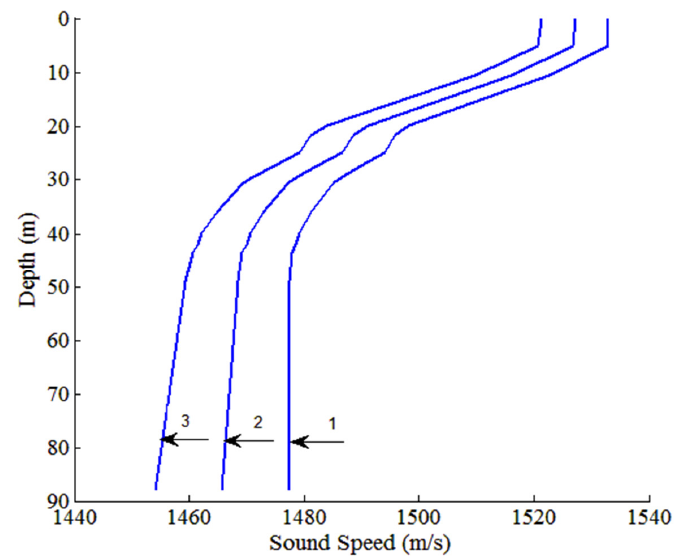
Figure 13. SSPs for different mismatched environments. Case 1 involves the actual SSP, Cases 2 and 3 involve mismatched SSPs. The error in the sound speed are 5.8 – 11.6 m/s in Case 2, and 11.6 m/s – 23.2 m/s in Case 3.